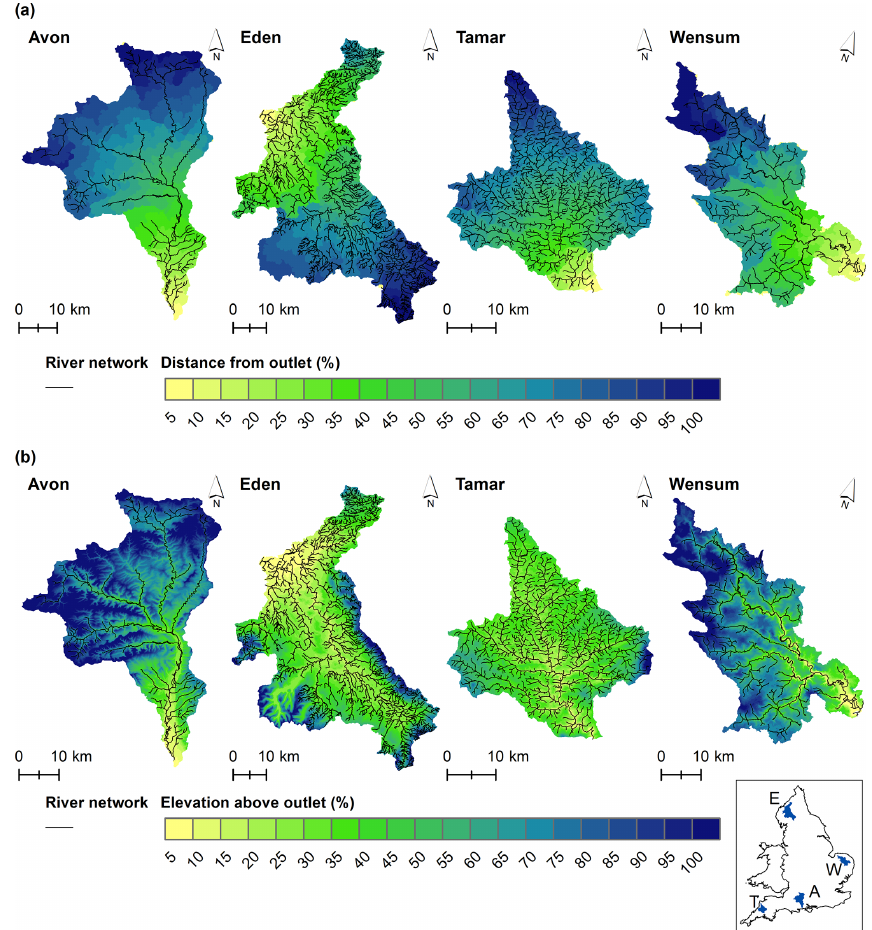
Figure 2. Distance and elevation intervals for each Demonstration Test Catchment: Avon (A), Eden (E), Tamar (T) and Wensum (W). (a) Percentage distance intervals used to calculate distance network density. (b) Percentage elevation intervals used to calculate elevation network density. Map of catchment locations in England in the bottom-right